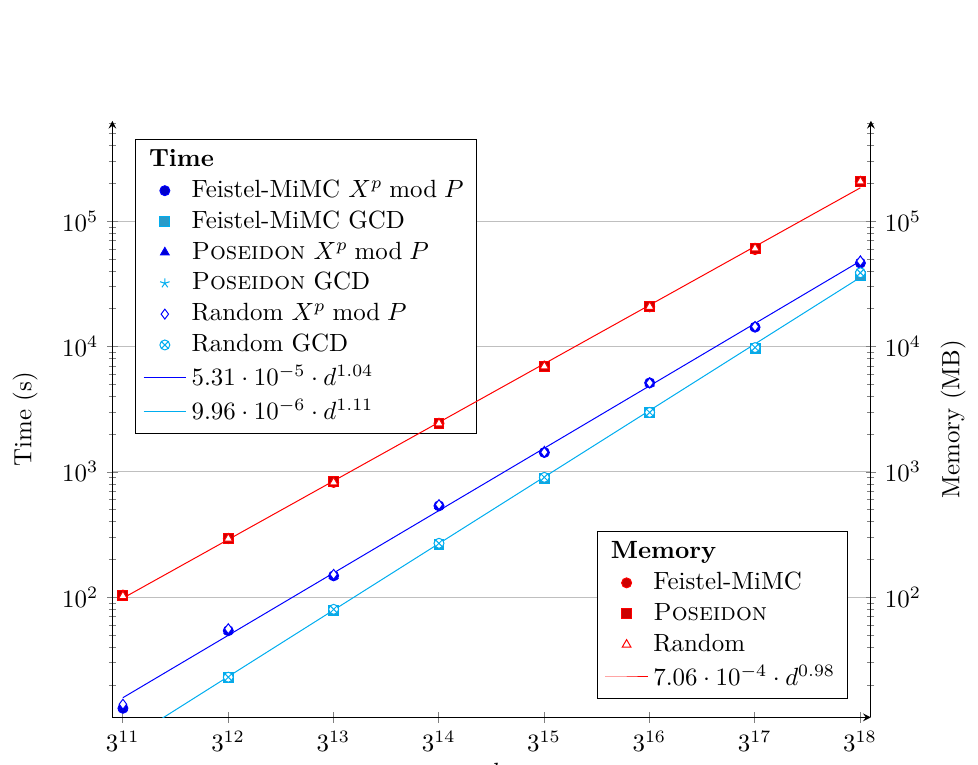
Figure 12: Benchmarks of univariate root finding with NTL (using 1 core of an Intel Xeon